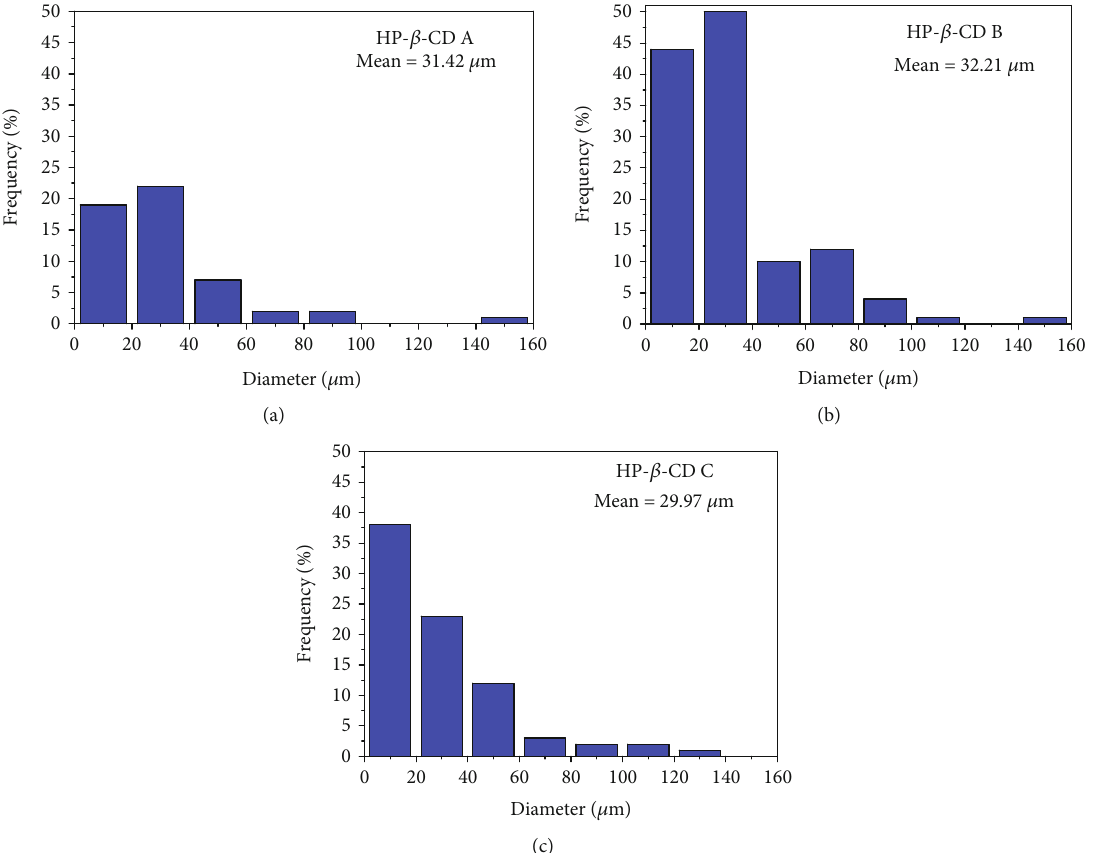
Figure 3: Size distributions of the particles in pure cyclodextrins: HP- β -CD A (a), HP- β -CD B (b), and HP- β -CD C (c). The mean diameter is given in